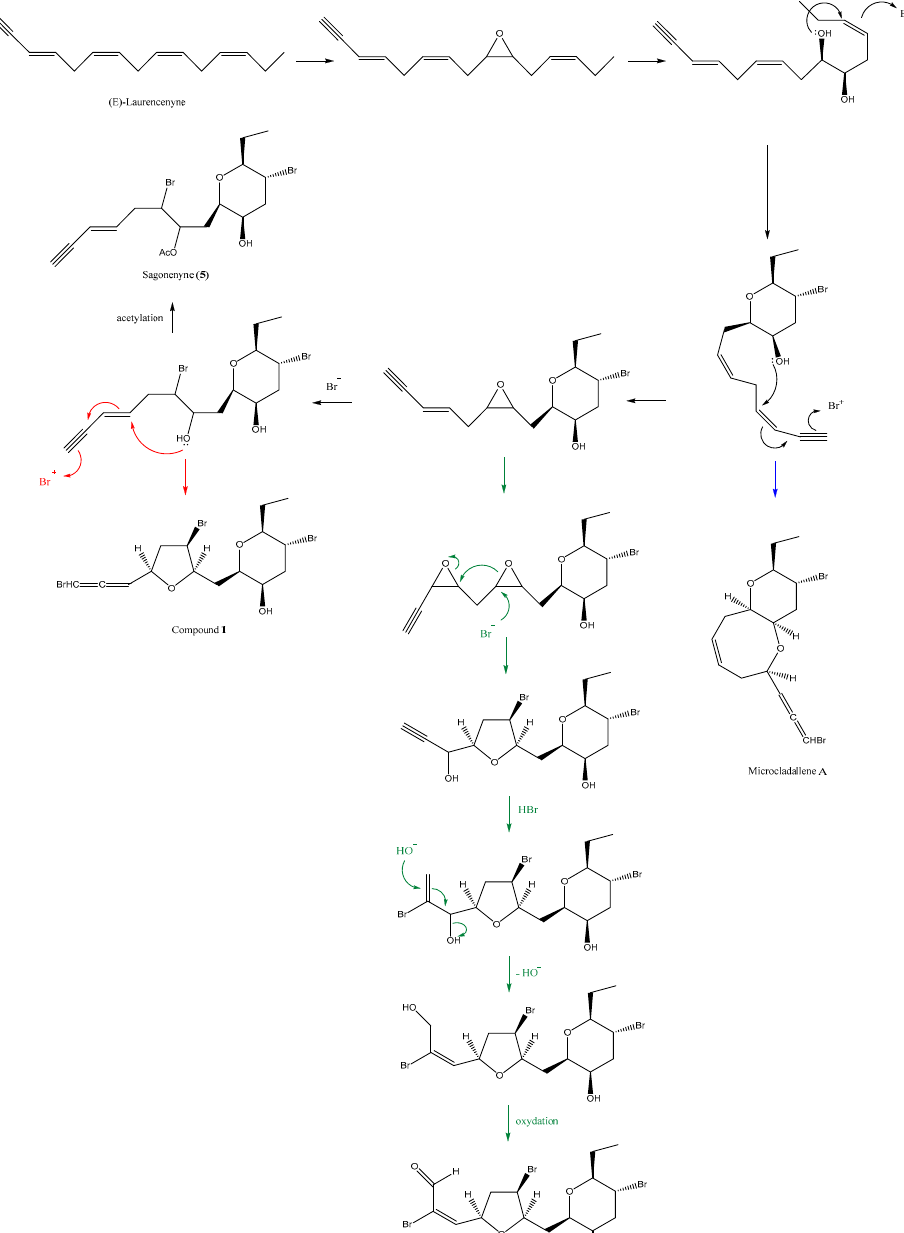
Figure 3. Hypothetic biogenesis of compounds 1 , 2, and microcladallene A.